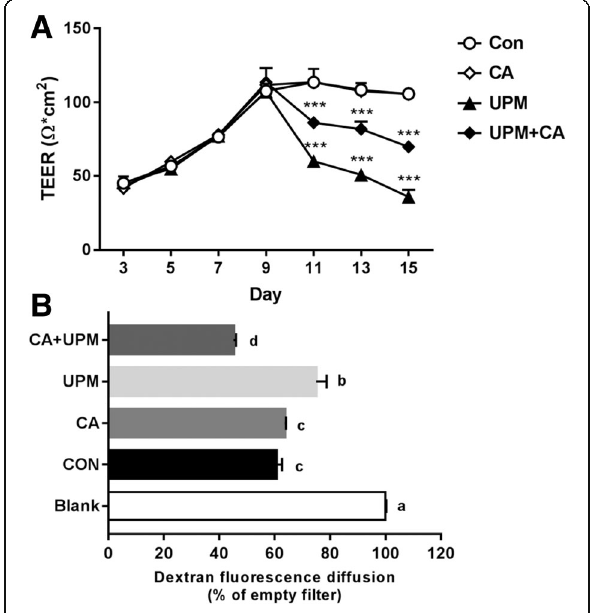
Fig. 5 Effect of CA on epithelial barrier integrity after exposure to UPM. a Transmembrane epithelial resistance (TEER) was measured using a voltohmmeter. Cells were cultured under non-treated, only CA, only UPM, and CA + UPM treated conditions for 0 – 15 days. CA (10 μ M) was applied on day 8 for 24 h, and UPM (100 μ g/mL) on day 9 for 6 h. Asterisks denote significant difference compared to each day control, p < 0.001, two-way ANOVA. b Paracellular permeability assay was performed using cells cultured with FITC-dextran 4000 Da (final concentration, 0.17 mg/mL). An empty filter was used as the negative control. After pretreatment with 10 μ M CA for 24 h, and NCI-H441 cells were incubated with UPM (100 μ g/mL) for 6 h. Data are means ± SD of three experiments with triplicate samples and different letters indicate significant differences at p < 0.05 by Tukey ’ s multiple comparisons